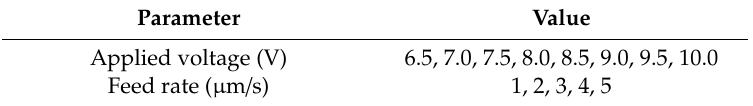
Table 3. Machining parameters for investigating the influence of feed rate and applied voltage.